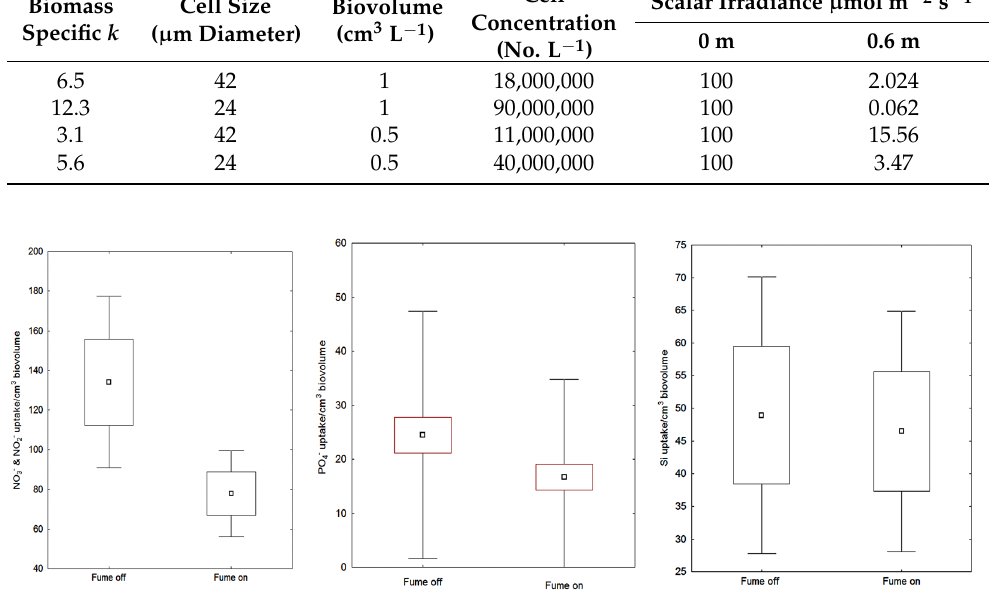
Figure 9. Biomass specific uptake of inorganic nutrients in the 300 m 3 reactor 2018–2021. Inner boxes = Mean +/ − S.E. and outer whiskers = Mean +/ − 0.95 confidence intervals. Left nitrate and nitrite, n = 117 and students t -test p = 0.041. Middle Orthophosphate, n = 127 and students t -test p = 0.66. Right Metasilicate, n = 95 and students t -test p = 0.86.